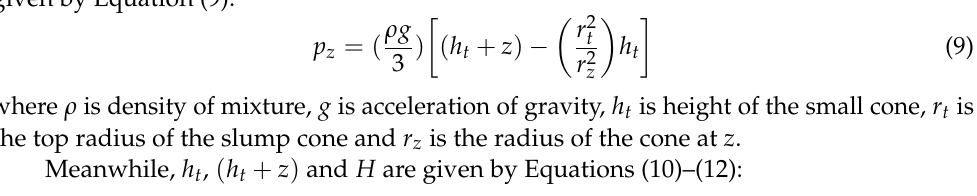
Figure 4. Schematic diagram of mixture before slump. Pressure